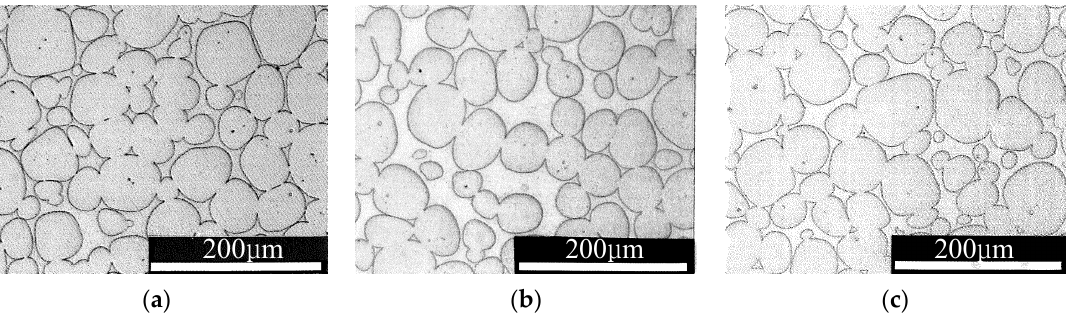
Figure 13. ( a ) Sintered microstructure before heat treatment; ( b ) heat-treated and water-cooled; ( c ) heat-treated and nitrogen-cooled.